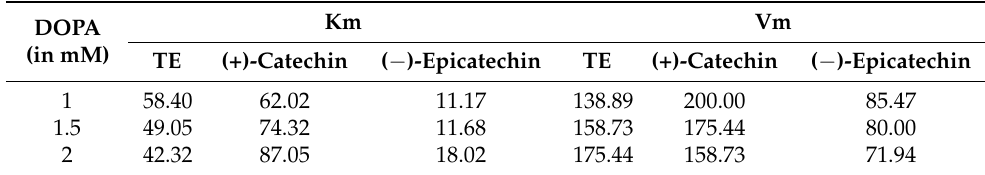
Table 2. Michaelis constant (Km) and maximum velocity (Vm) of tyrosinase activity in the presence of TE, (+)-catechin and ( − )-epicatechin.